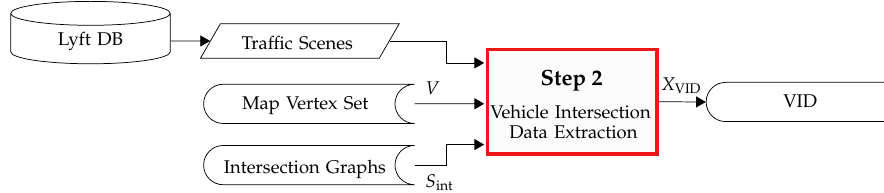
Figure 5. Overview of step 2 of the PROMOTING method: the route extraction. A detailed description of the VID extraction process is depicted in Figure 6.